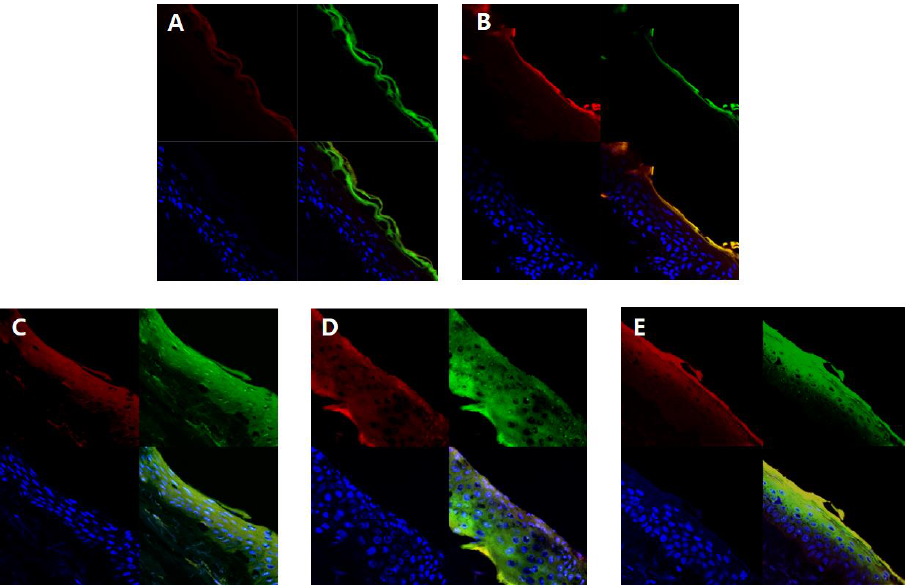
Figure 7. Fluorescence images of a cross-section of human skin incubating with nanoliposomes containing Rhodamine B (red) and fluorescein isothiocyanate (FITC) (green) for 12 h. Cellular nucleuses were stained with 4 ′ ,6-diamidino-2-phenylindole (DAPI) (blue). ( A ) 1,3-butylene glycol solution, ( B ) conventional nanoliposome, CLQ, ( C ) elastic nanoliposome (Sucrose stearate), MELQ3, ( D ) elastic nanoliposome (Sucrose distearate), DELQ3, ( E ) elastic nanoliposome (Sucrose tristearate), TELQ3.